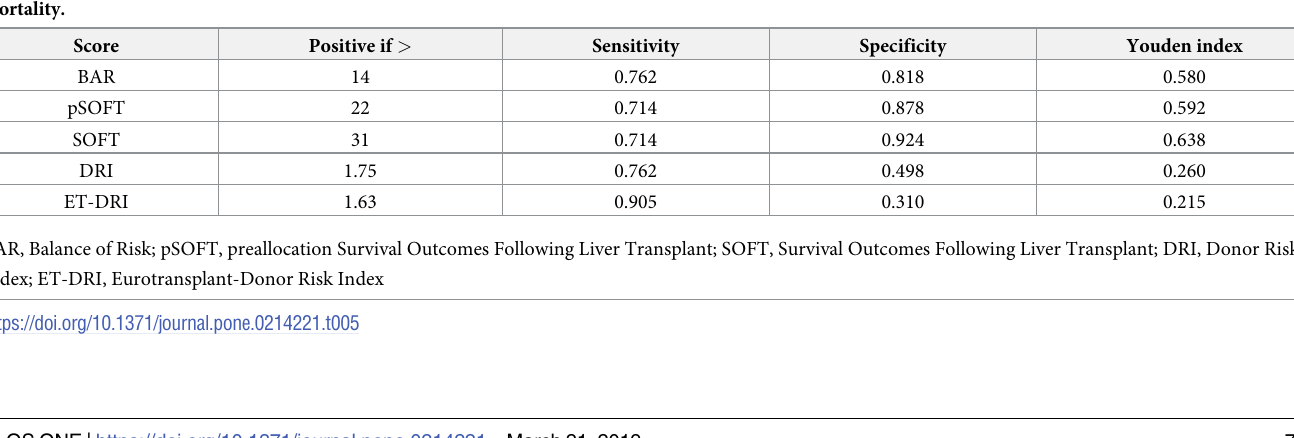
The association between perioperative outcome and the calculated values of the various scores were assessed further using the Spearman‘s correlation coefficient. A moderately strong but significant positive association was observed between the BAR, pSOFT and SOFT score values and the days spent on ICU (BAR: r = 0.523 p < 0.001; pSOFT: r = 0.511 p < 0.001; SOFT: r = 0.502 p < 0.001), length of hospital stay (BAR: r = 0.487 p < 0.001; pSOFT: r = 0.534 p < 0.001; SOFT: r = 0.532 p < 0.001) as well as the cumulative 90-day CCI (BAR: r = 0.469 p < 0.001; pSOFT: r = 0.434 p < 0.001; SOFT: r = 0.441 p < 0.001) (Table 7). No meaningful cor- relation was found between the above-mentioned outcome measures and the DRI and ET-DRI scores (Table 7).